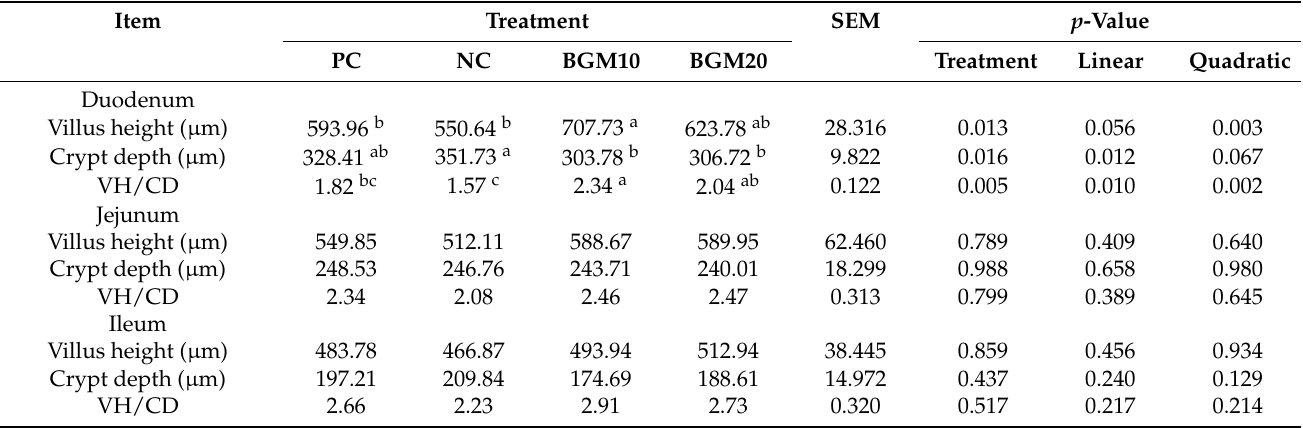
Table 7. Effect of dietary BGM with multienzyme addition on intestinal morphology in weaning pigs 1,2